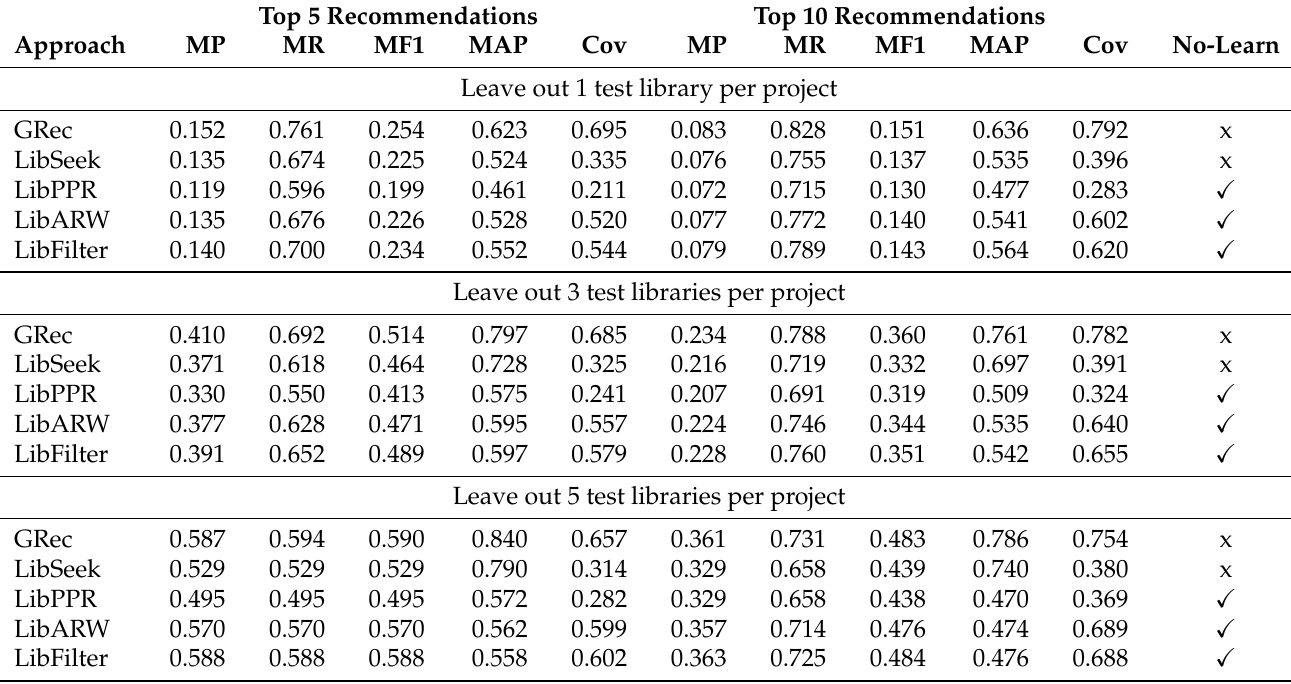
Table 2. Comparison of library recommendation